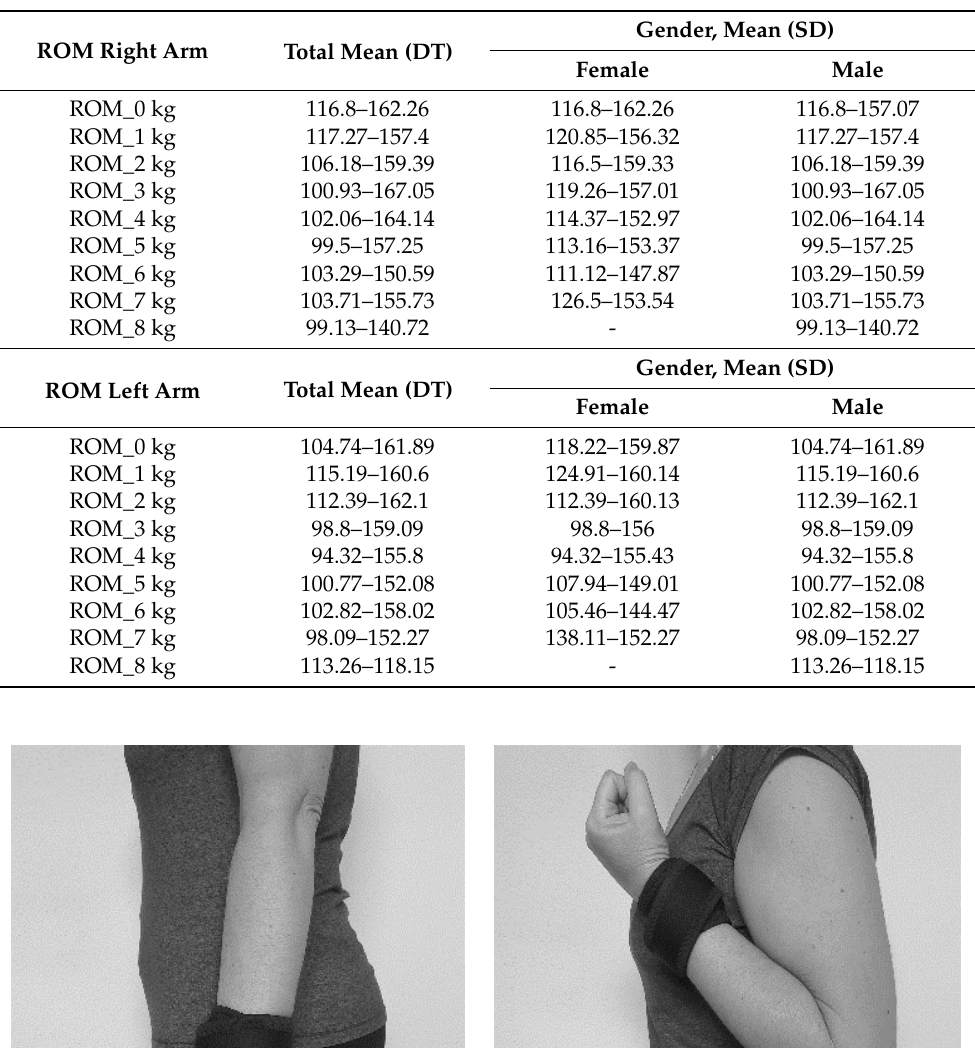
Table 2. ROM of the right and left arm.